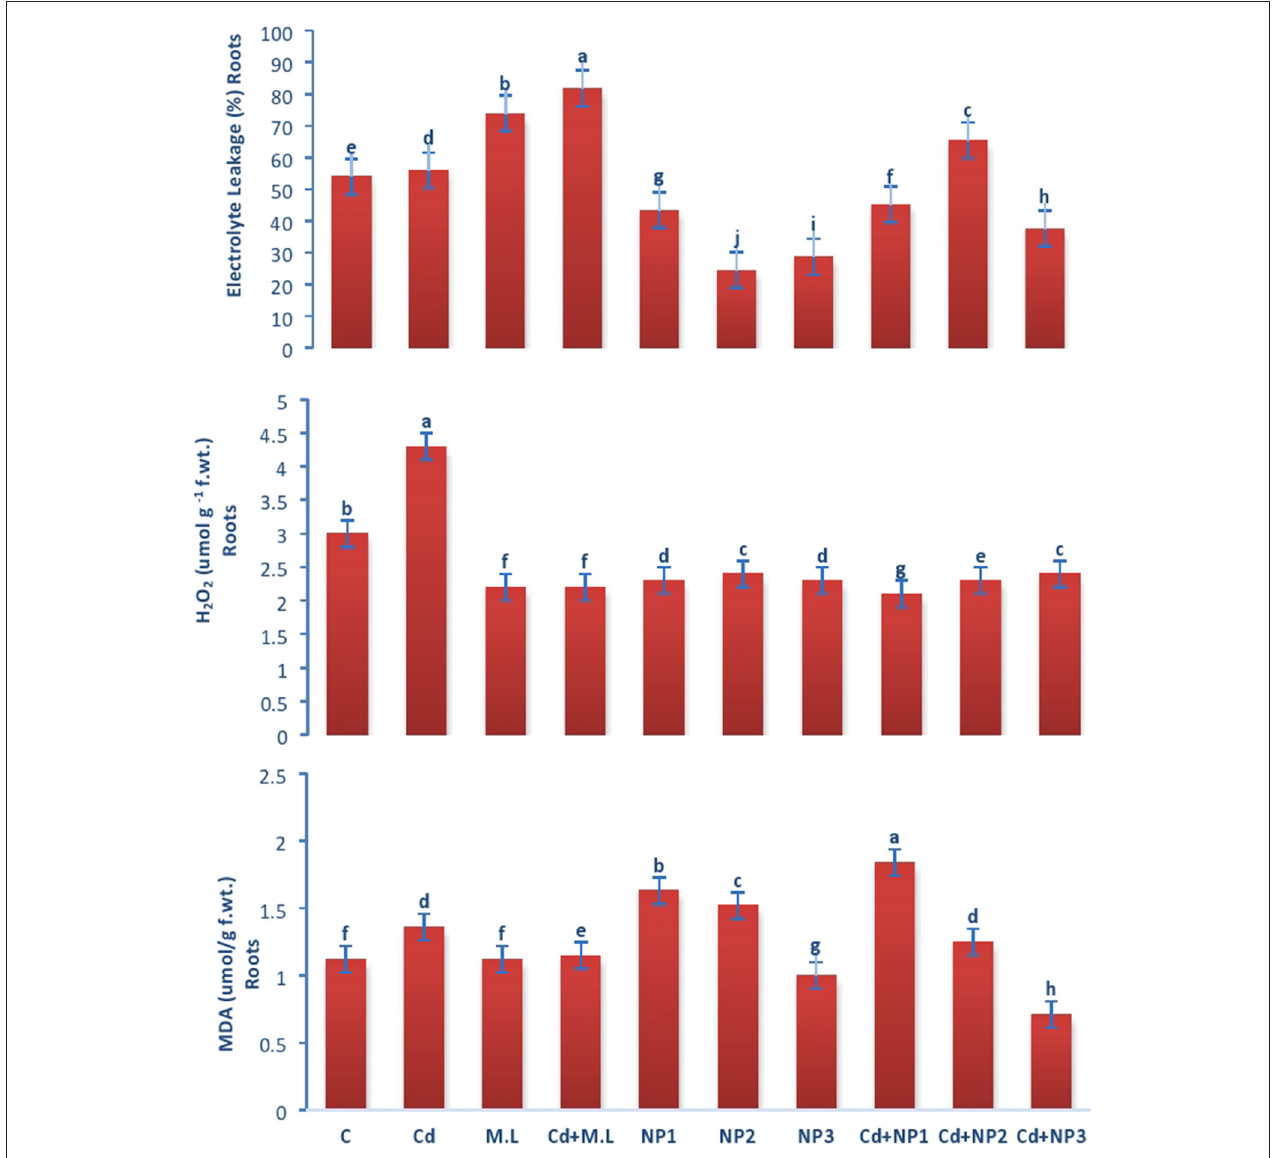
FIGURE 7 | Effects of MZnO–NPs on EL, H 2 O 2 , and MDA under Cd stress in Linseed roots. Different letters indicate significant difference between the treatments. Data are means ± SE ( n = 5). Non-identical letters specify significant difference at P ≤ 0.05. C, Control; Cd, 100 mg/kg Cd; M. L, Moringa oleifera leaves; NP1, 100 mg/L MZnO-NPs; NP2, 500 mg/L MZnO-NPs; NP3, 1 g/L